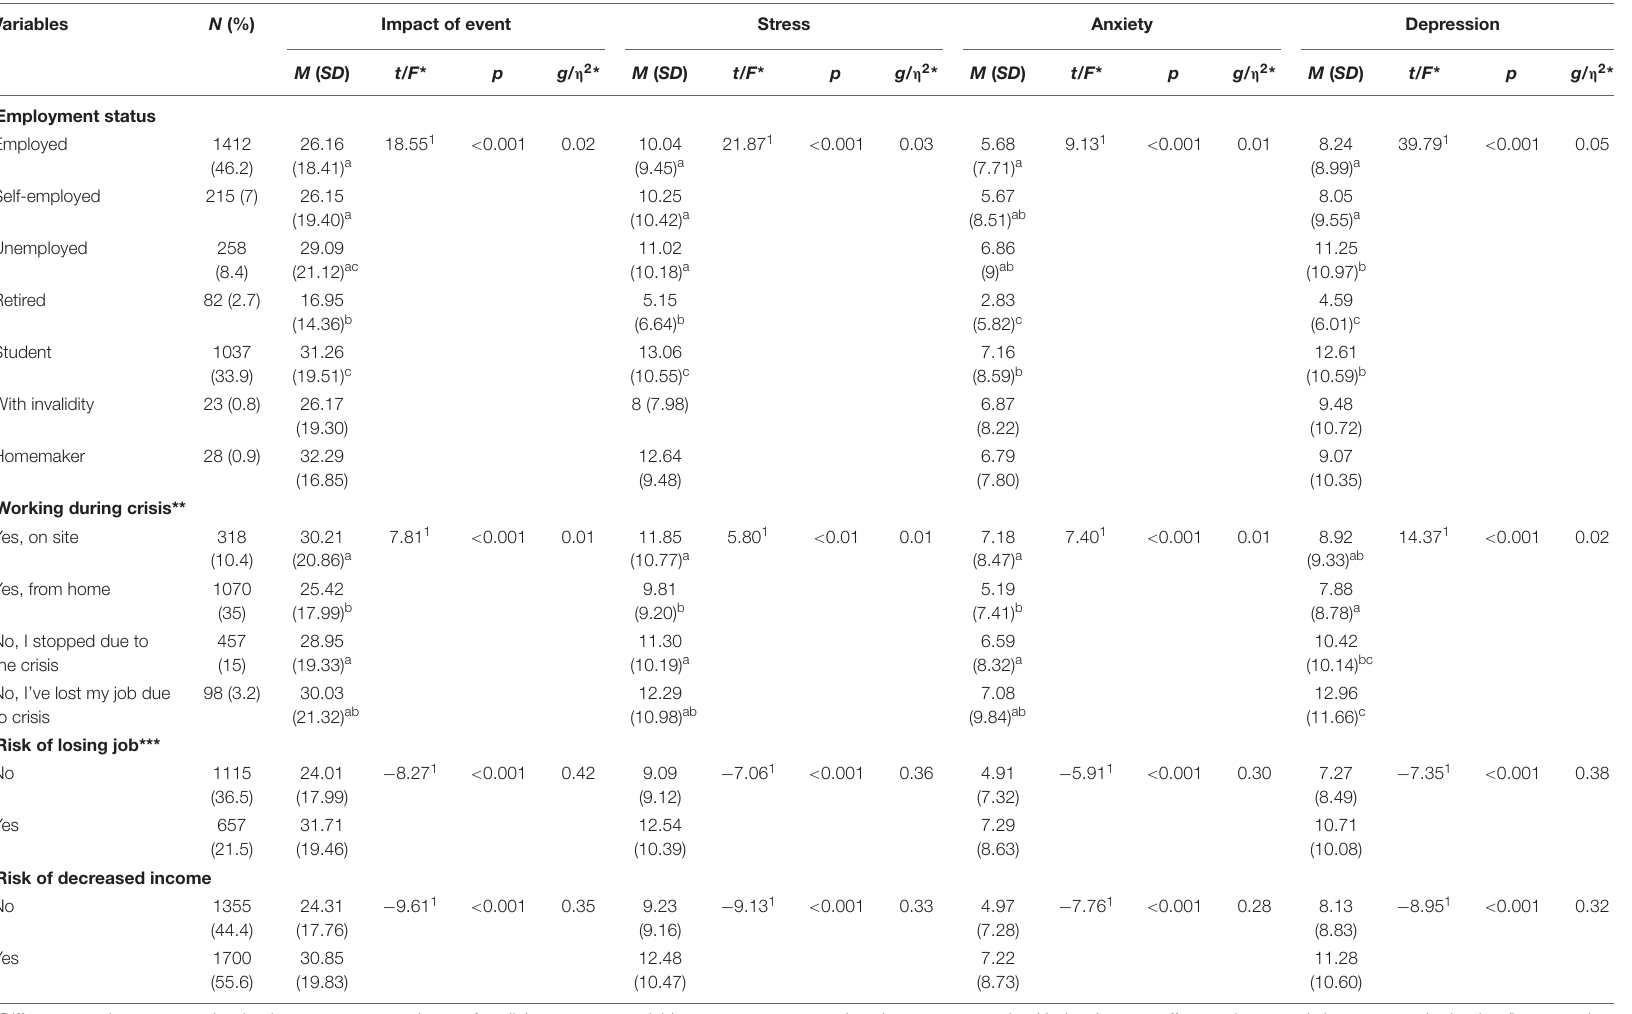
TABLE 5 | Association between work-related variables and the psychological impact of the COVID-19 pandemic as well as mental health status during the pandemic ( N = 3055). Variables N (%) Impact of event Stress Anxiety